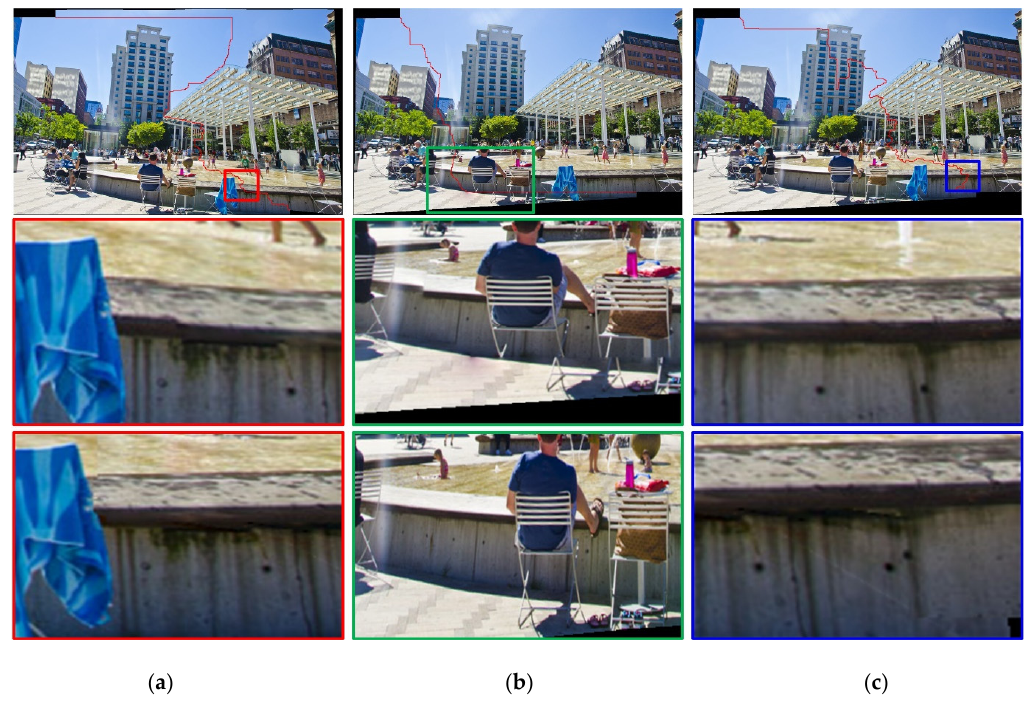
Figure 5. Comparison of three seam-driven methods and the used seams. ( a ) The perceptual seam-cutting method [18]. ( b ) The traditional seam-driven method based on color and texture information. ( c ) The proposed method. The first row shows the stitching results and the used seams with respective to the three different methods. The second row shows partial enlargements of the region through which the seam passes. The third row shows the partial enlargements of the region in the